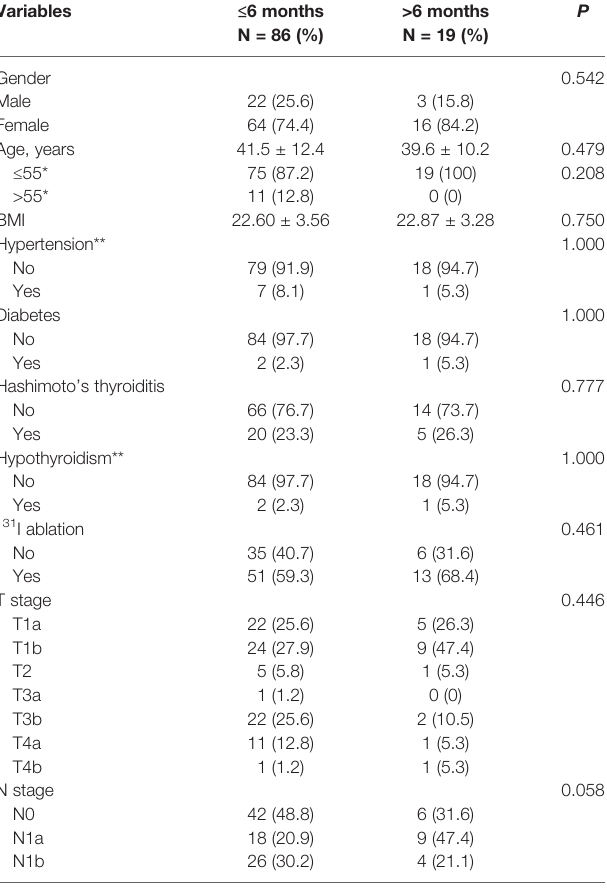
TABLE 5 | Surgical and laboratory variables of patients recovering from protracted hypoparathyroidism within or beyond six months after surgery.